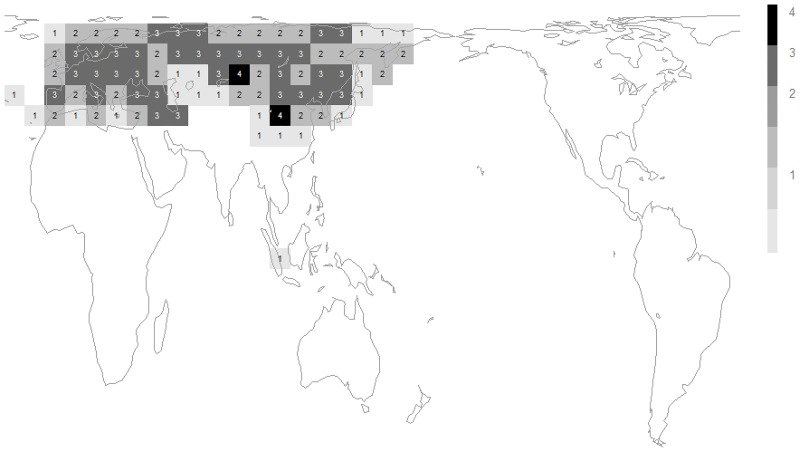
Diversity from different phases of speciation of the subgenus Megabombus.Data sources and grid map as in Fig 5. Richness in the species B. hortorum to B. sushkini and ‘unnamed’ from Fig 4.